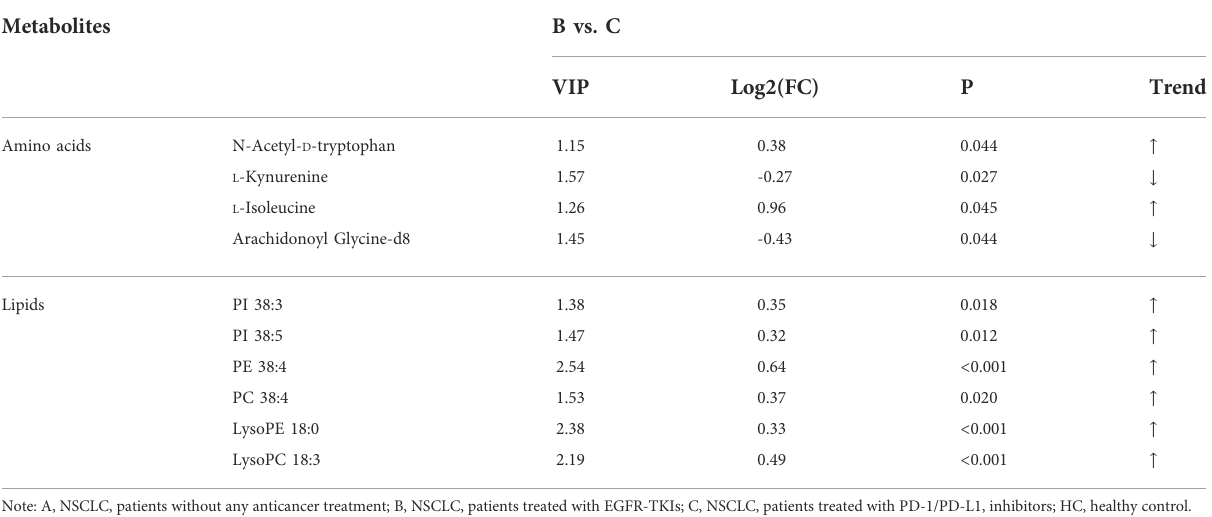
TABLE 4 List of statistically signi fi cant metabolites in B vs C comparison.